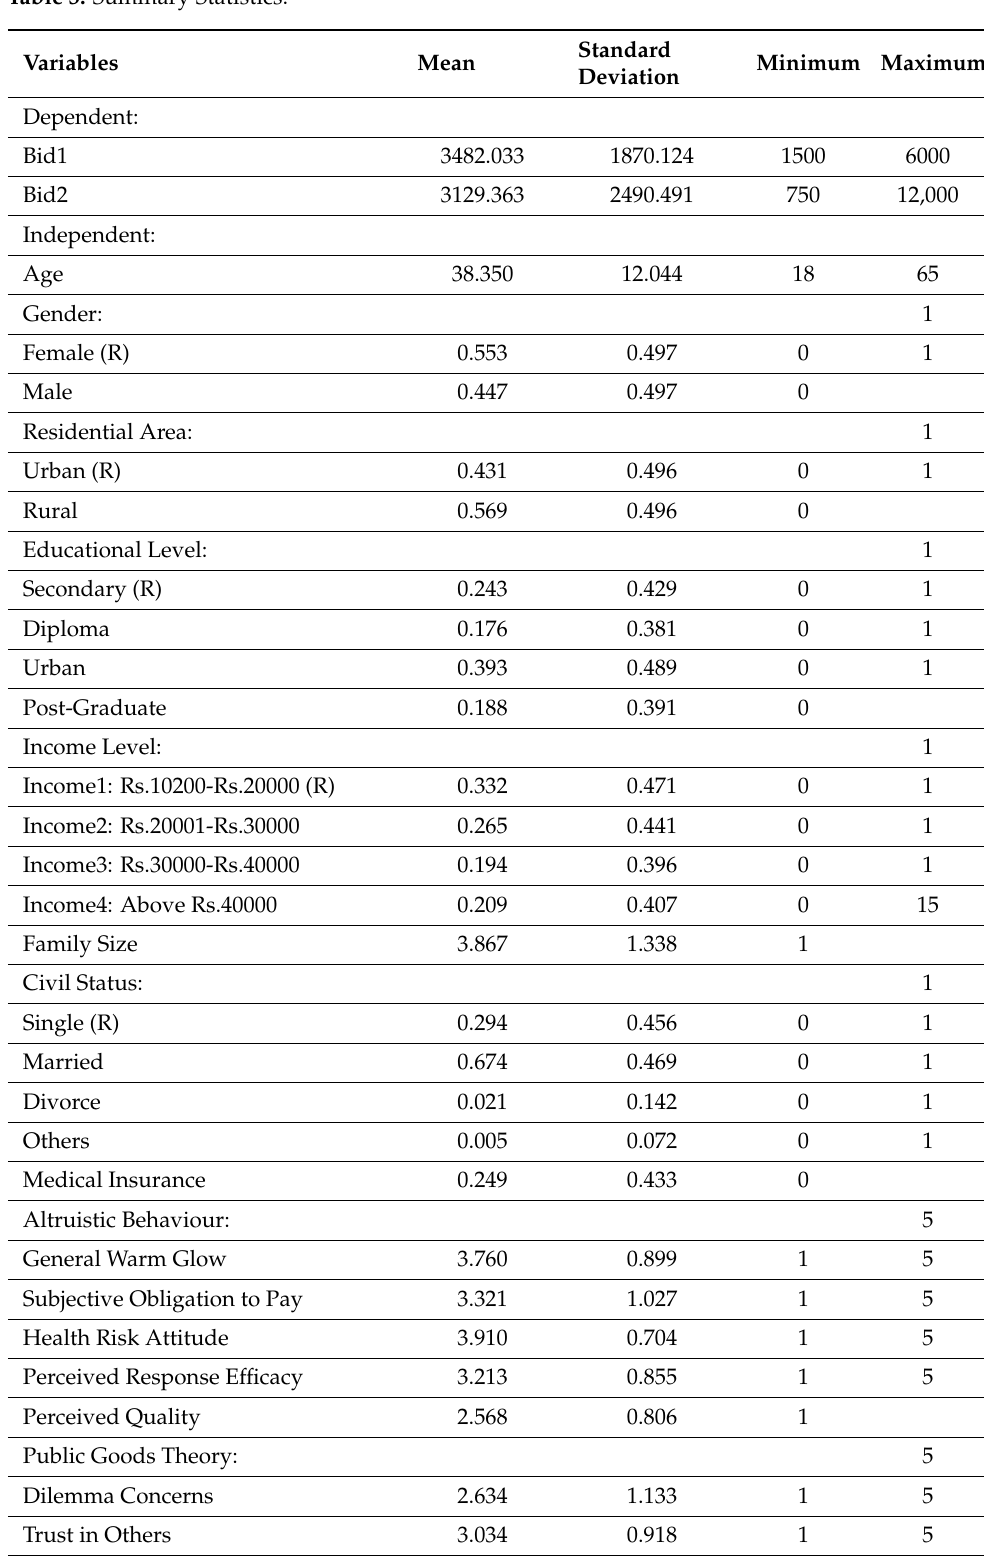
Table 3. Summary